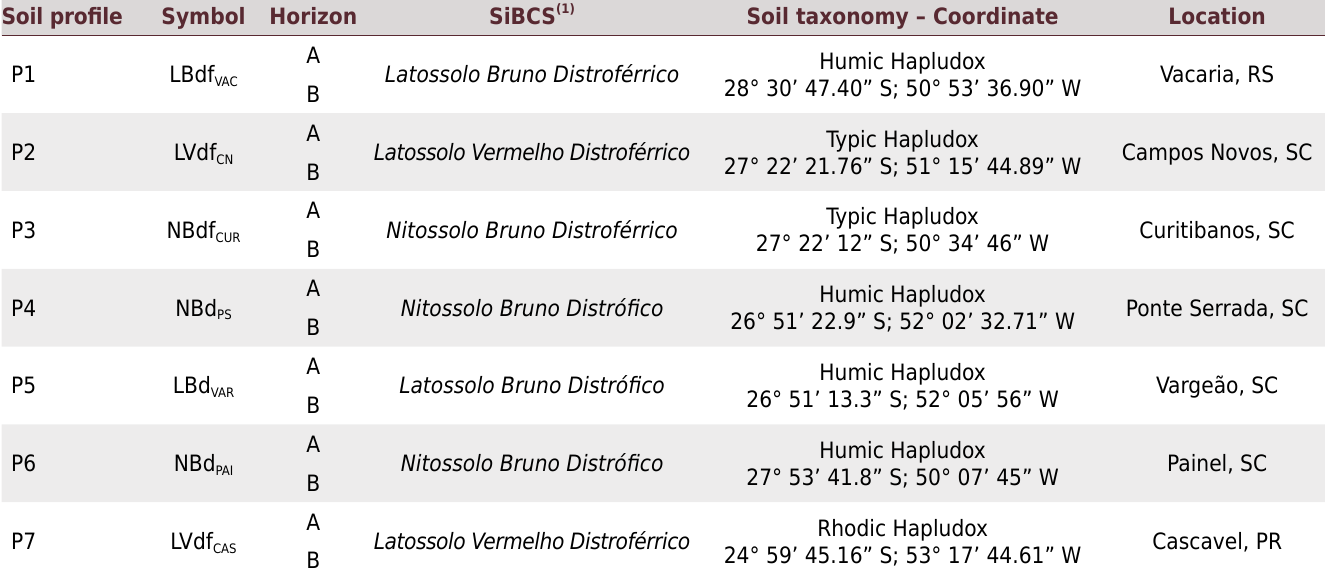
Table 1. Classification and location of the soils studied, correlated with soil taxonomy classification Soil